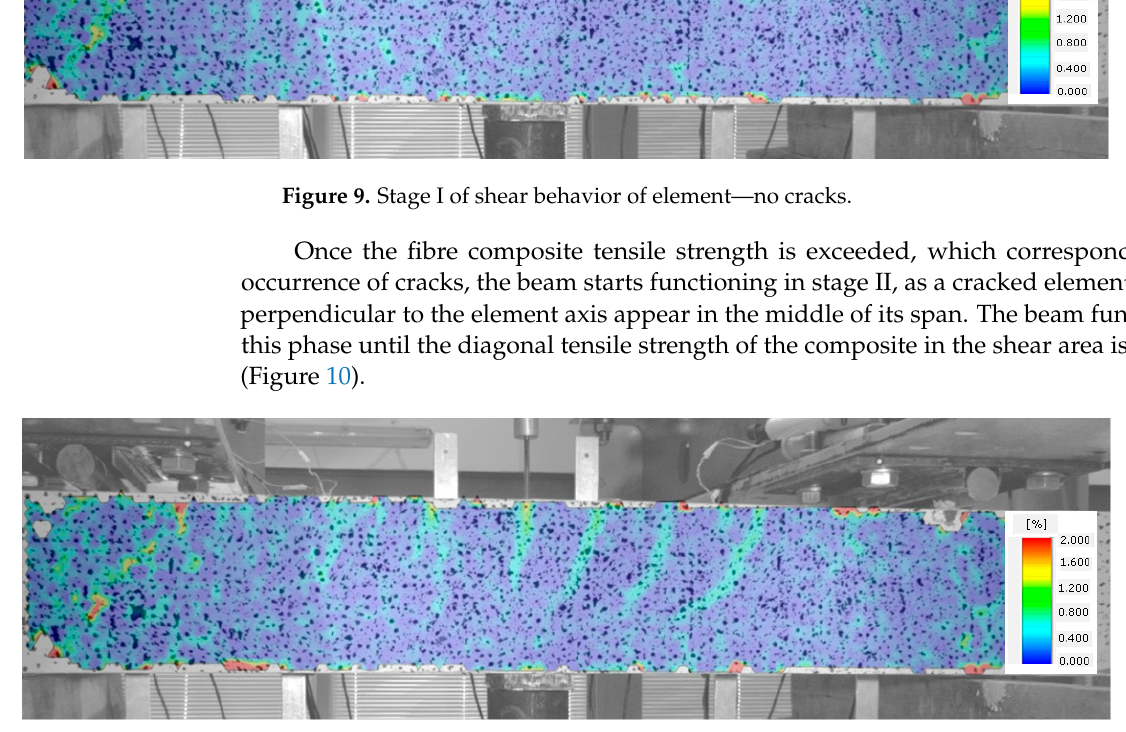
Figure 10. Stage II of shear behavior of element—flexural cracks have occurred.